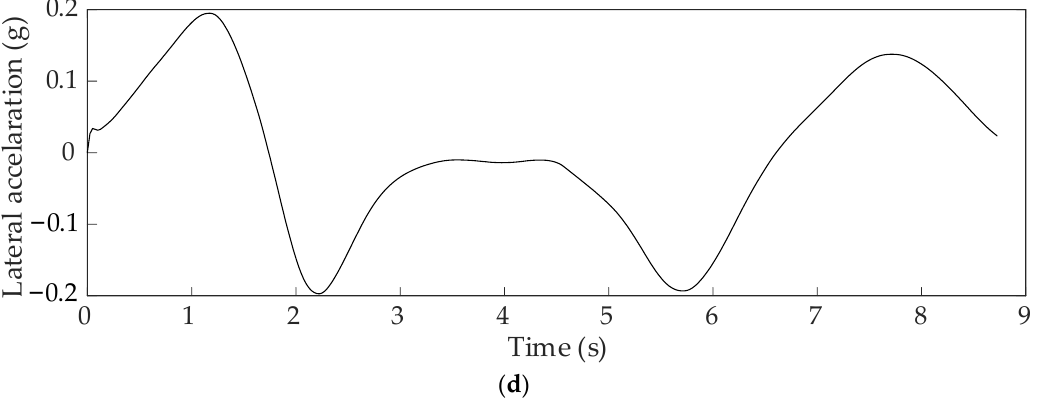
Figure 19. The path tracking results of the coherence path in a dynamic scenario with driving in the same direction. ( a ) The path following result. ( b ) The path following error. ( c ) The yaw velocity. ( d ) The lateral acceleration.